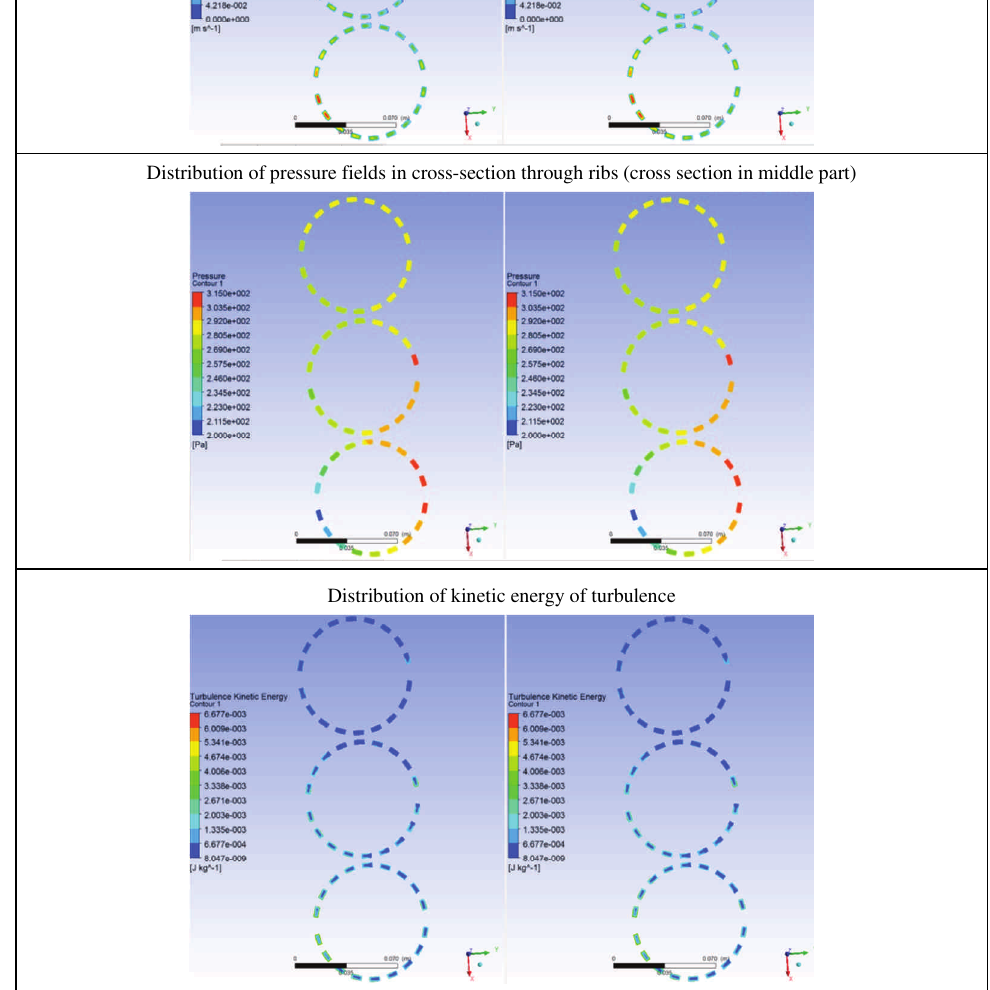
Fig. 12. Visualization of the effect of turbulence intensity on the computational